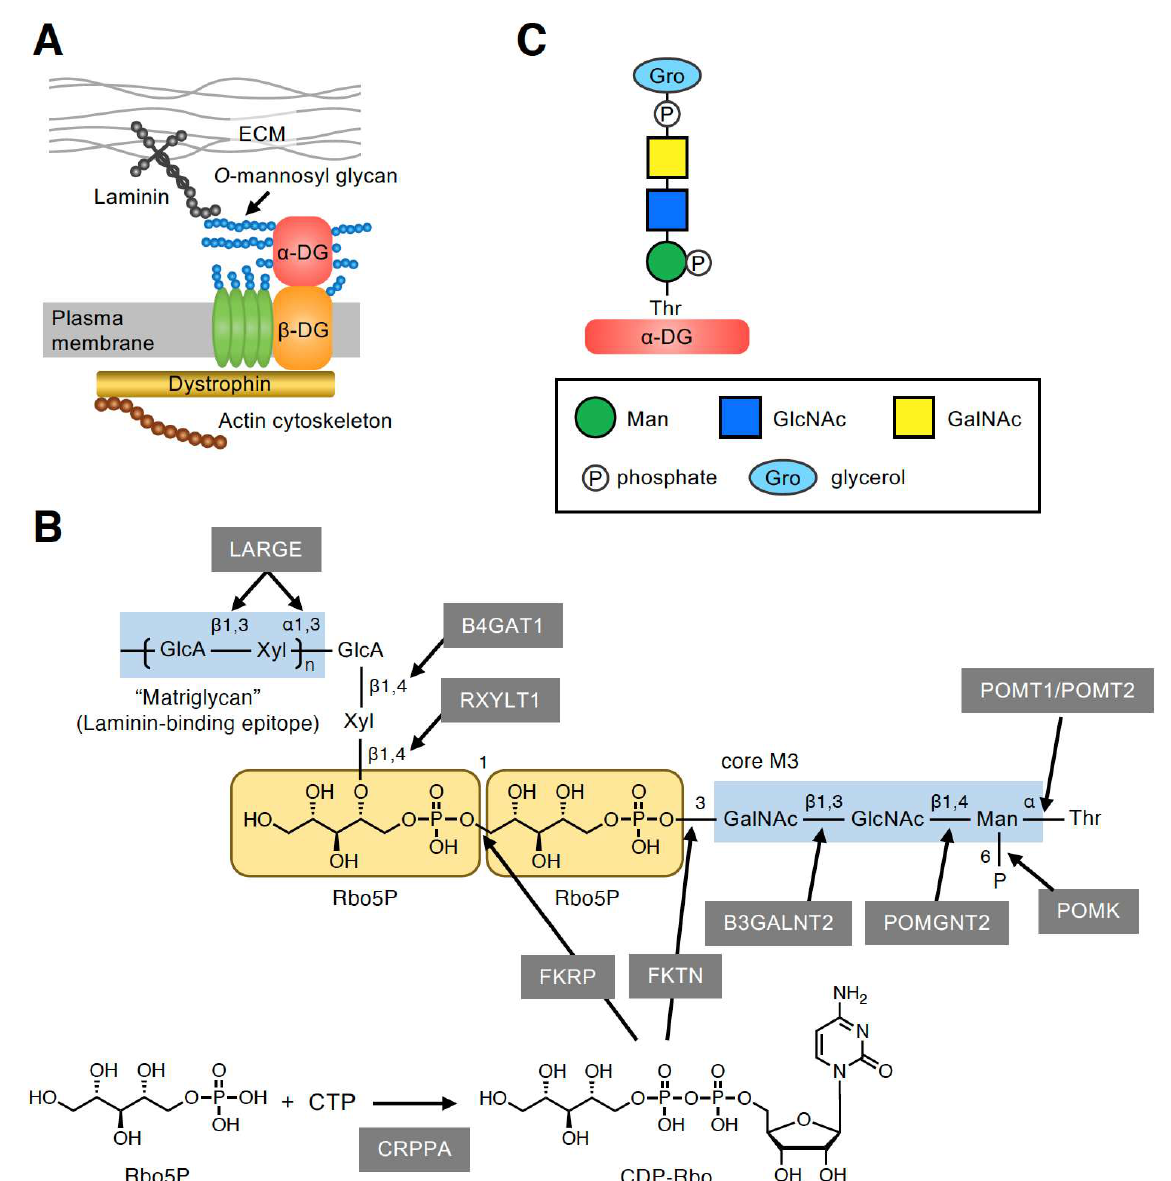
Figure 1. Core M3-type glycan on α -DG. ( A ) The plasma membrane-localized protein complex DGC connects the ECM and actin cytoskeleton. The characteristic O -mannosyl glycan on α -DG, namely, the core M3-type glycan, is responsible for binding to some ECM proteins such as laminin. ( B ) Structure of the functional laminin-binding core M3-type glycan and the enzymes involved in its biosynthesis. ( C ) GroP-containing core M3-type glycan structure identified from the glycan analysis of small truncated recombinant α -DG in HEK293T and HCT116 cells [7]. The symbol legends are indicated in the lower box.